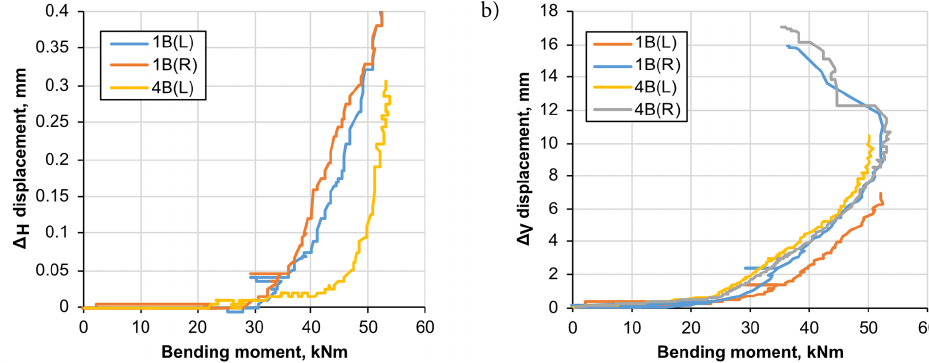
Figure 16. Displacement of the end plate in the tension zone of the joint: a – Δ H ; b – Δ V